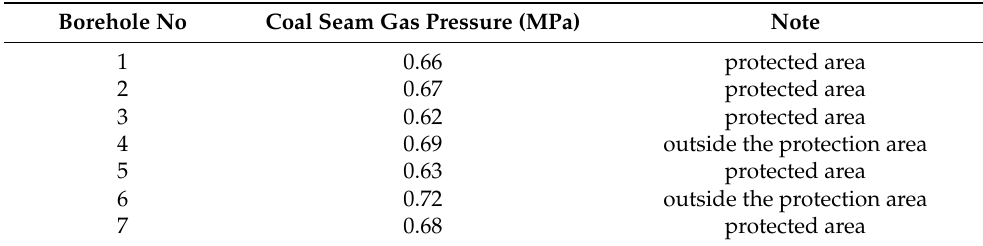
Table 4. Determination results of residual gas pressure in coal seam.